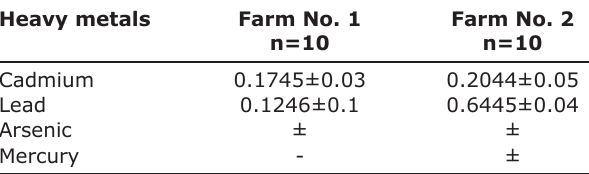
Table-4: The average content of heavy metals in horse feces samples,